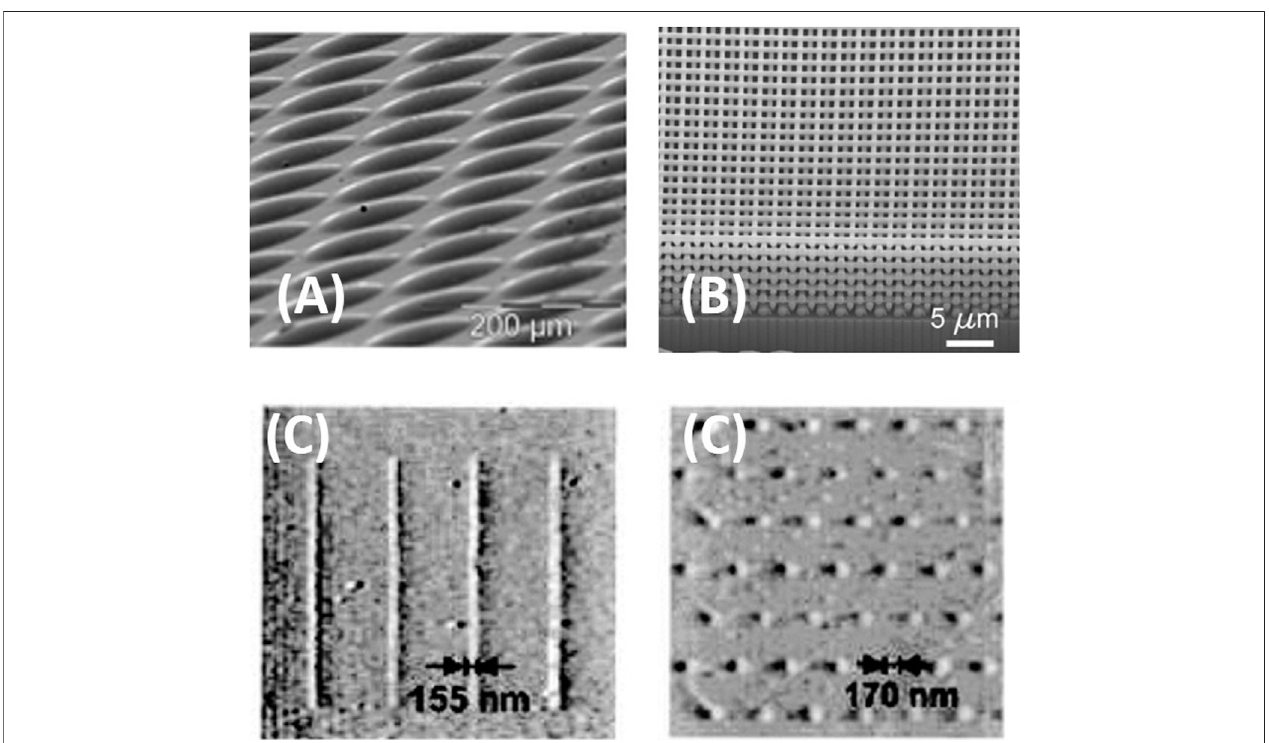
FIGURE 4 | (A) SEM images of 25-layer inkjet printed microdot arrays realized from a sol aged 48hs and in situ functionalized with 5 mol% MPTES and 5 mol% TFTS. Reprinted with permission from Fousseret et al. (2010). Copyright © 2010 American Chemical Society. (B) Focused ion beam (FIB)-milled cross-section of direct ink writing 3D calcined TiO 2 structure heated to 715 ° C. Reproduced with permission from Duoss et al. (2007). Copyright © 2007 WILEY-VCH Verlag GmbH and Co. KGaA, Weinheim. (C) Topographic AFM image of composite tin oxide/P-123 nanostructures on silicon oxide, dot array of aluminum oxide/P-123 composite nanostructures formed on silicon. Reprinted with permission from Su et al. (2002), copyright © 2002 American Chemical Society.